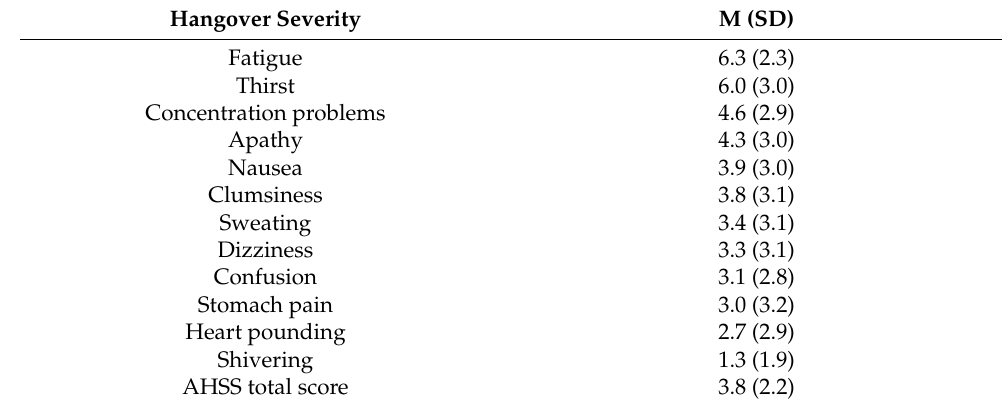
Table 3. Means and standard deviations of individual hangover items and overall hangover severity.